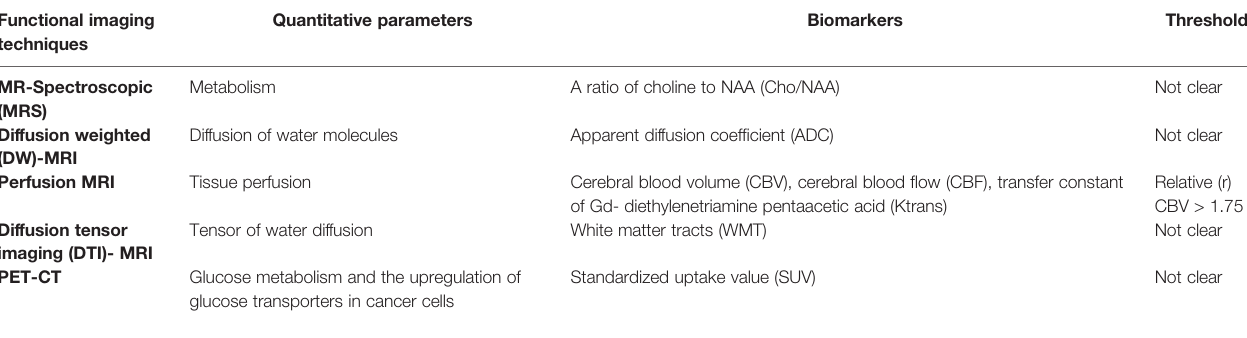
TABLE 1 | An overview of functional imaging techniques. Functional imaging